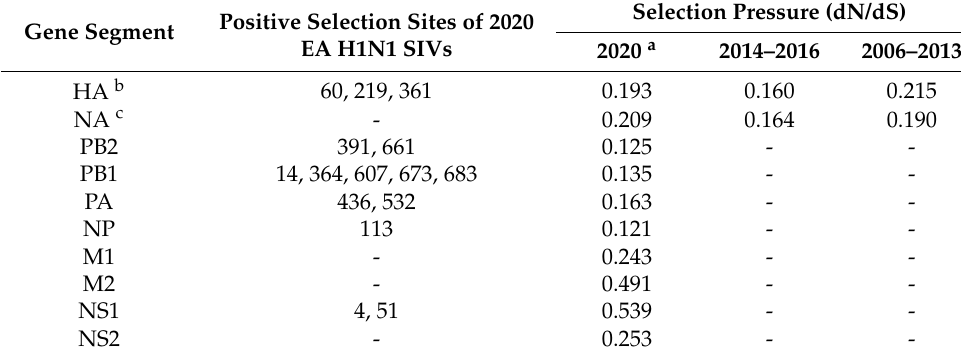
Table 3. Analysis of the selection pressure of Liaoning EA H1N1 SIVs.